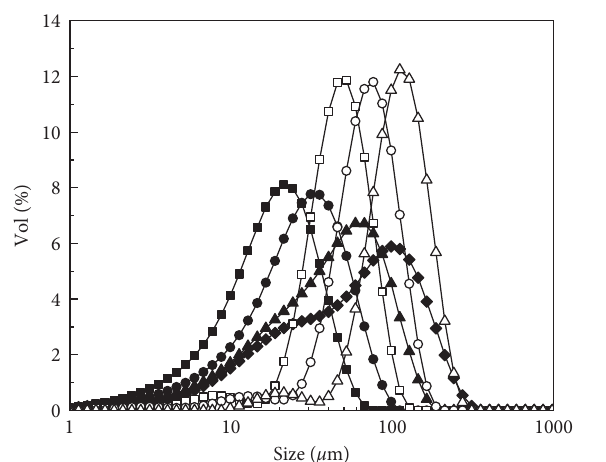
Figure 1: The PSD of the sieved TiH 2 powder fractions. — ■ —0–38 μ m, — ● —0–63 μ m, — ▲ —0–88 μ m, — ◆ —0–125 μ m, — □ —38–63 μ m, — ○ —63–88 μ m, and — △ —88–125 μ m.